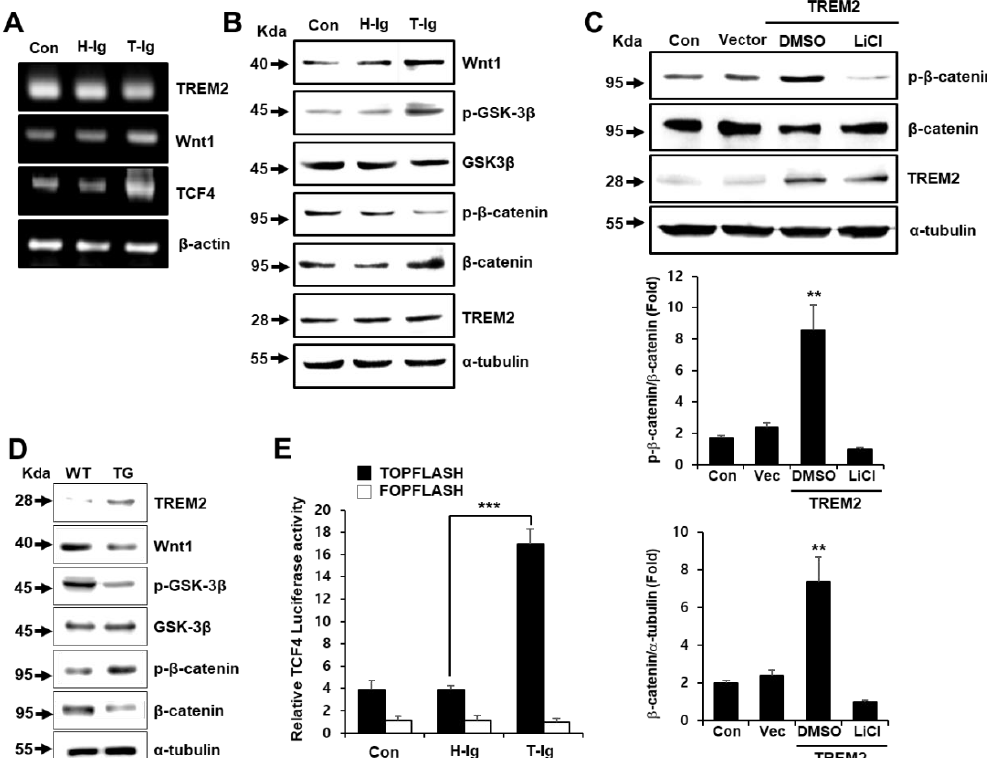
Figure 3. TREM2 suppresses the Wnt / β -catenin signaling pathway in HT29 cells. ( A ) The indicated mRNA expression levels were analyzed by RT-PCR, ( B ) and the expression levels of Wnt / β -catenin signaling-related proteins were measured by Western blot in HT29 cells treated with H-Ig or T-Ig (2 µ g / mL) for 24 h. ( C ) Western blot analysis was performed using protein from HT29 cells transfected with plasmids containing the TREM2 gene or vector. The GSK-3 β inhibitor LiCl (1 µ M) was added for 10 min before analysis. The relative protein expression was quantitatively analyzed by densitometry (lower panel). ( D ) The expression levels of the indicated proteins in cells isolated from the large intestine of WT littermate and TREM2-TG mice were determined by Western blot. ( E ) TCF4 luciferase activity was determined in HT29 cells treated with H-Ig or T-Ig (2 µ g / mL) for 24 h. The data are representative of three independent experiments (** p < 0.01, *** p < 0.001).